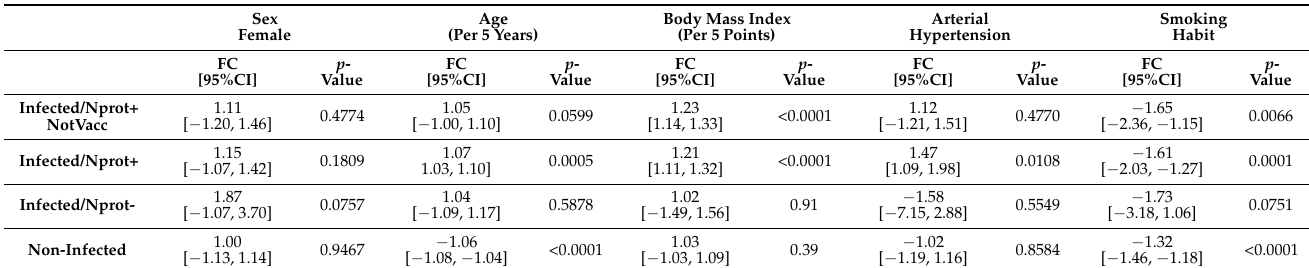
Table 3. Fold changes (FCs), 95% confidence intervals (95%CI) and p -values for the association